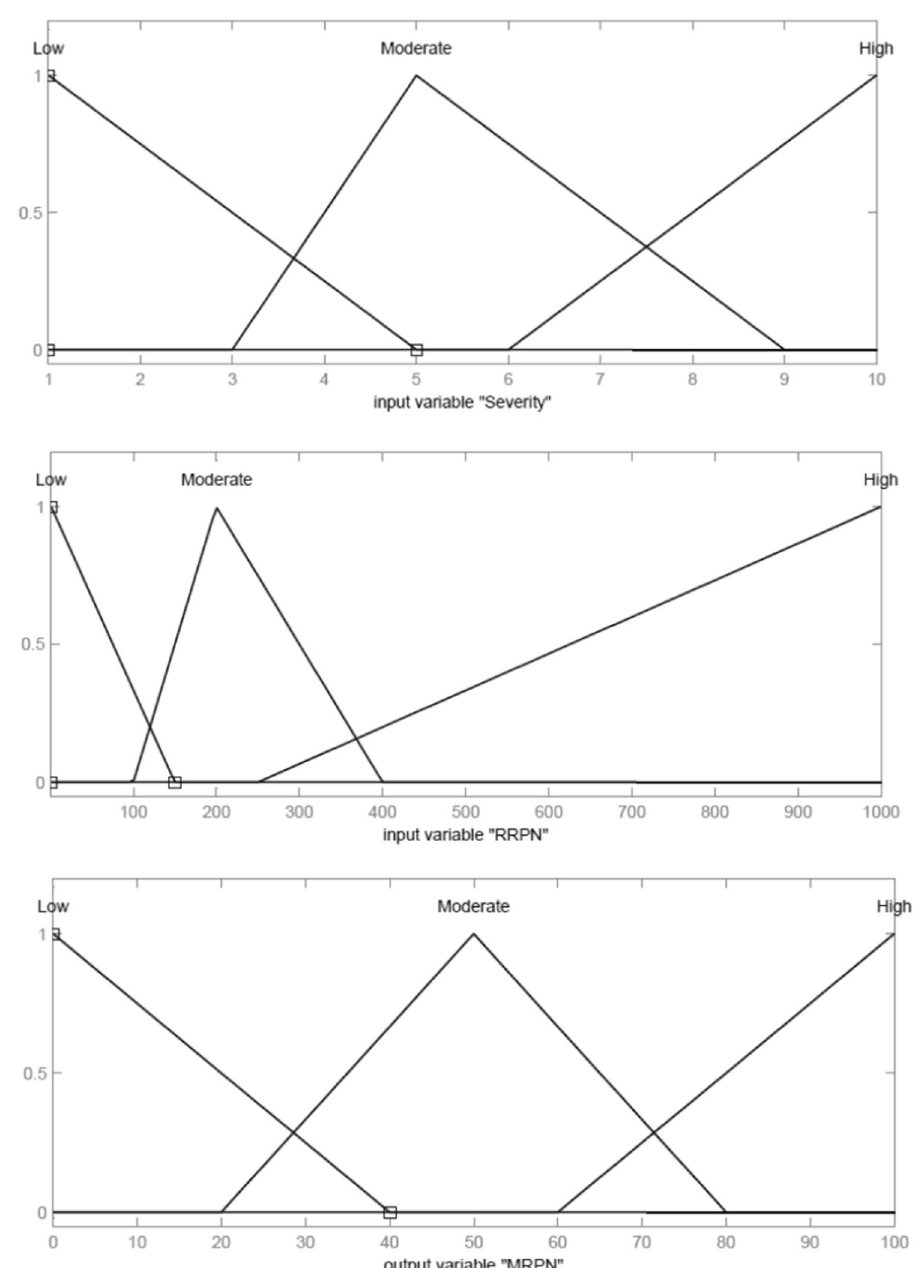
Fig. 2 Shape of the member- ship functions of a input vari- able “Severity”, b input variable “RRPN”, and c output variable “MRPN” for fuzzy system